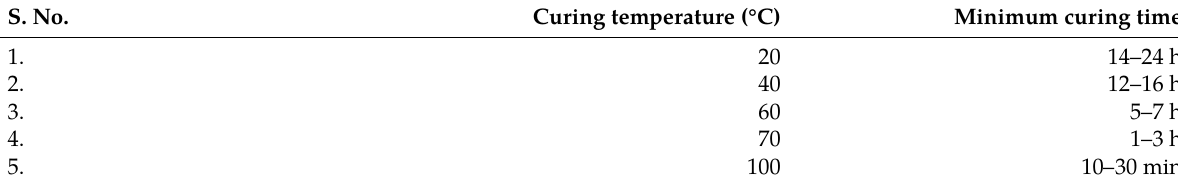
Table 3: Curing temperature and time for DGEBA with hardener (HY-951). S.